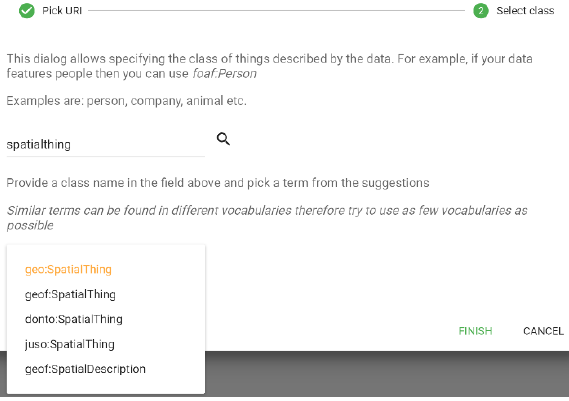
Figure 3. The Select Class dialog uses the Link Open Vocabularies service to search for relevant